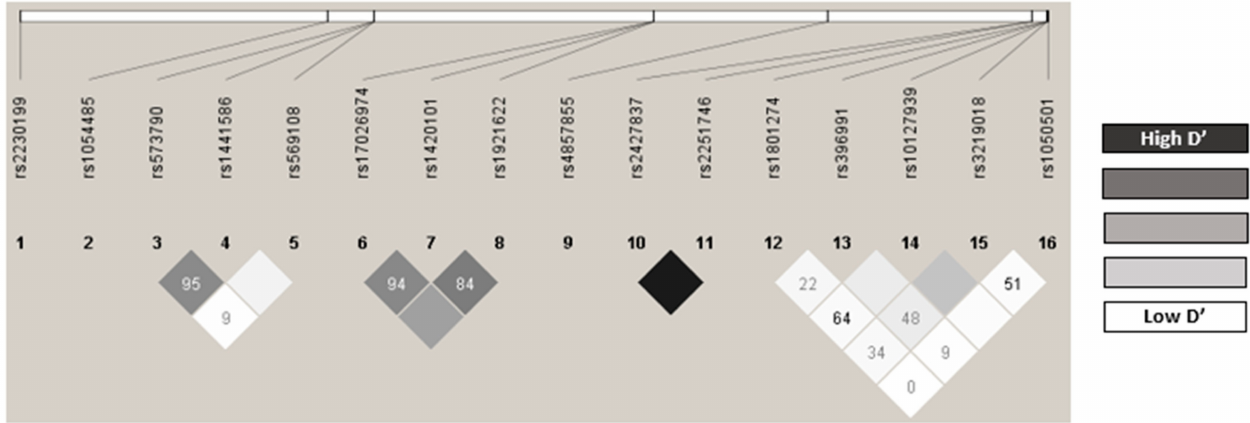
Figure 1. Linkage disequilibrium